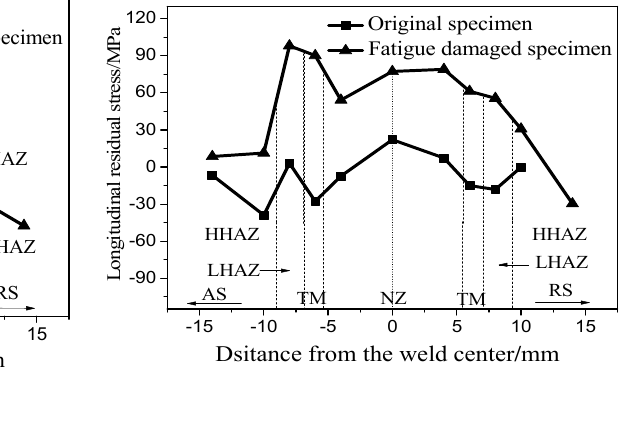
Figure 5. ( a ) Transverse and ( b ) longitudinal residual stress distributions of upper surface in the joint.